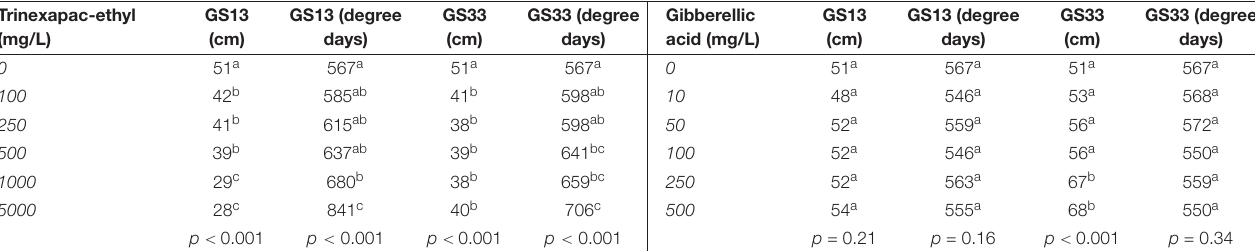
TABLE 5 | The final height and thermal time to flowering produced from two different timing applications of (a) trinexapac-ethyl and (b) gibberellic acid. Trinexapac-ethyl (mg/L)